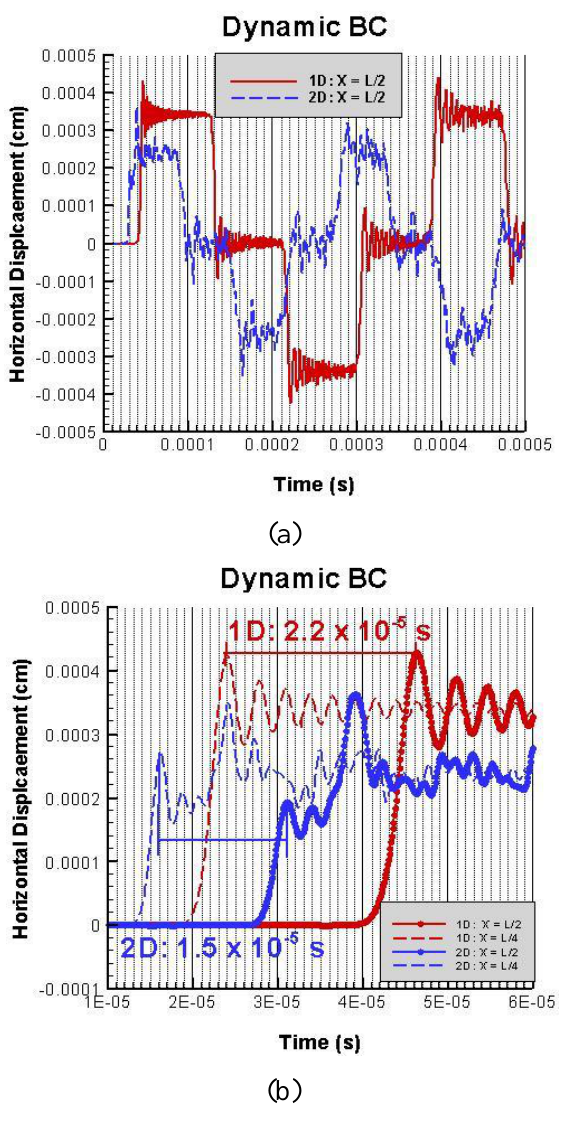
Figure 15. HPLM prediction of horizontal displacement for 1D and 2D bar, respectively. (a) horizontal displacement recorded at X = L/ 2; (b) horizontal displacement recorded at X = L/ 4 and X = L/ 2. Dynamic boundary condition is applied,